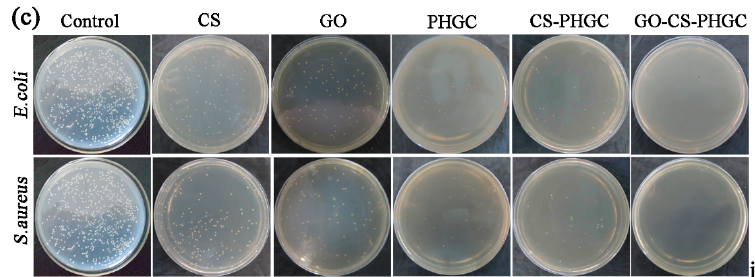
Figure 8. Reduction of bacterial colonies of ( a ) E. coli and ( b ) S. aureus after the exposure to Control, GO, CS, PHGC, CS-PHGC and GO-CS-PHGC composites. (The reduction = ( A − B )/ A ; A is the number of surviving bacteria colonies on the control plate and B is that on the sample plate); ( c ) photographs of E. coli and S. aureus colonies grew on LB agar plates upon a 60 min exposure to Control, CS, GO, PHGC, CS-PHGC and GO-CS-PHGC.